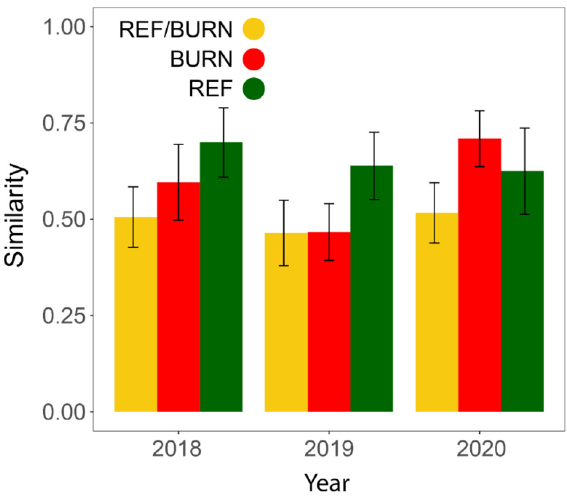
Figure 5. Average Sørensen’s similarity coefficient within reference and burn sites and between burn and reference sites, for all years.